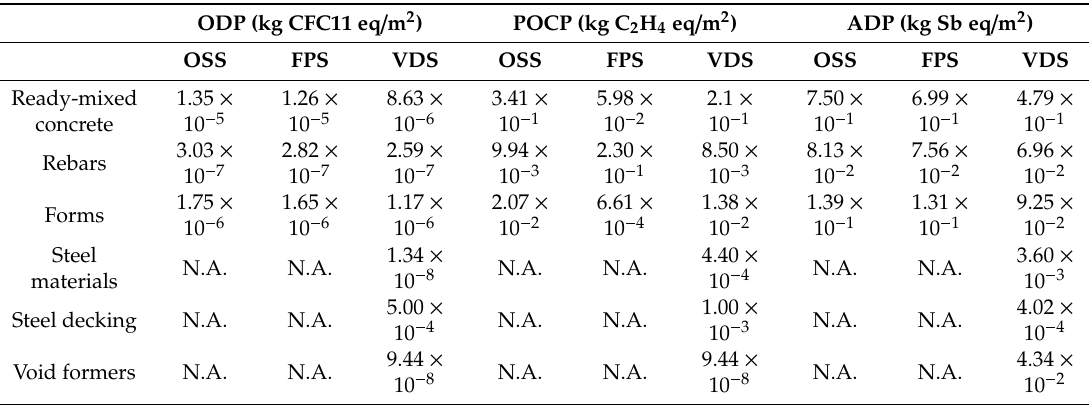
Table 7. The environmental impacts of building materials